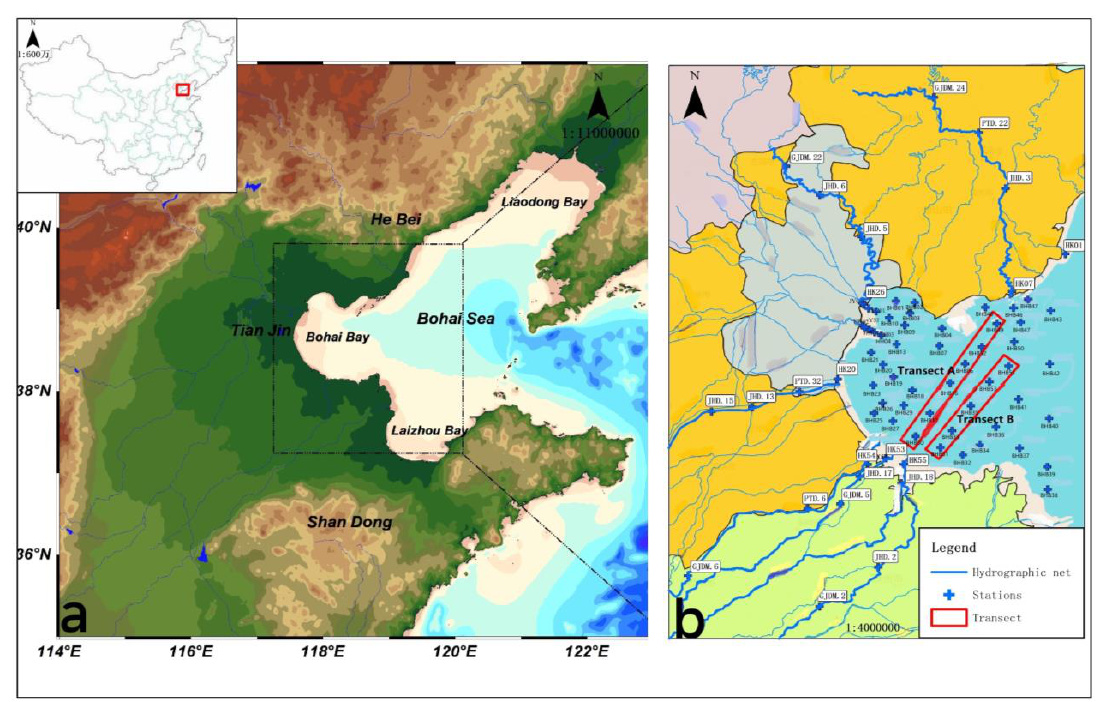
Figure 1. Location map of sampling stations of Bohai Bay and relevant rivers flowing into the bay in summer 2020. The inserted regional map indicates the location of the Bohai Bay in northeastern China. The red rectangles represent the transects we investigated. Scale on the upper left map is 1:600,000,000.